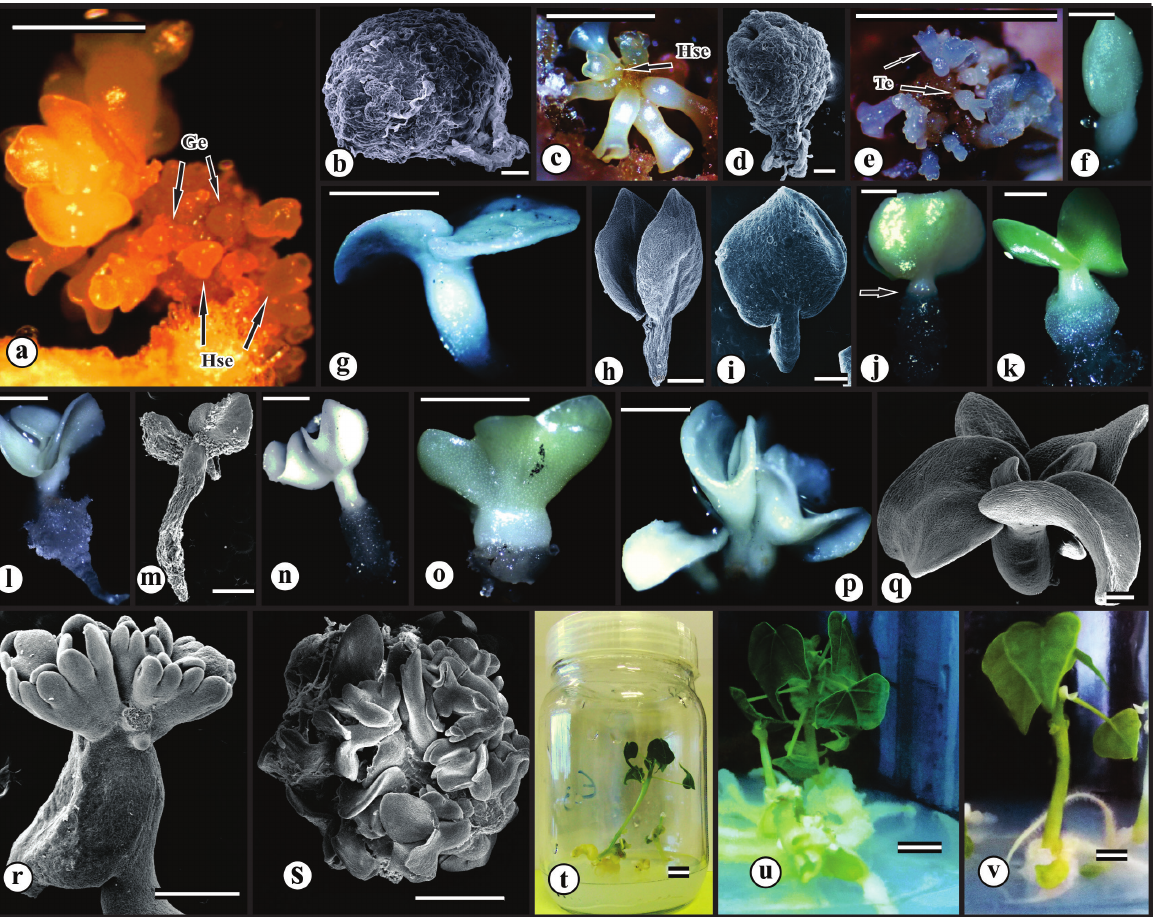
Figure 3 - Maturation of somatic embryos of C . papaya L. ‘Golden THB’ somatic embryos at different stages of development: ( a ) Embryogenic callus with somatic embryos; ( b ) Globular embryo; ( c , d ) Heart-shaped somatic embryos; ( e , f ) Torpedo-shaped somatic embryos; ( g , h ) Morphologically normal cotyledonary embryos; ( i ) Zygotic embryo. Germinated somatic embryos: ( j ) Normal embryo (arrow) detail of the transition region between root and shoot; ( k , l ) Normal germinated embryo with chlorophyllated cotyledon leaves; ( m ) Normal germinated embryo. Abnormal embryos: ( n ) Germinated abnormal embryo; ( o ) Embryo with fused cotyledons; ( p ) Fused somatic embryos; ( q ) Polycotyledonay embryo; ( r ) Secondary embryogenesis; ( s ) Globular mass of somatic embryos. Normal seedlings developed from somatic embryos: ( t ) 30 days after germination; ( u , v ) 65 days after germination. Abbreviations: Ge = globular embryo; Hse = heart-shaped embryo; Te = torpedo-shaped embryo. Bar: 100 µm ( b , d ); 200 µm ( h , q ); 500µm ( i , m , r ); 0.5 mm ( f ); 1.0 mm ( a , c , e , g , j , k , l , n , o , p , s ); 0.5 cm ( u , v ); 1.0 cm ( t